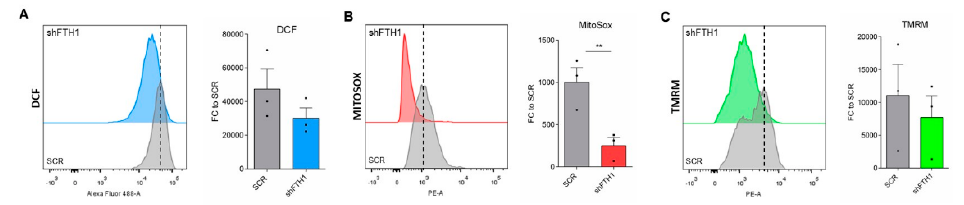
Figure 2. Analysis of ROS levels and mitochondrial functionality in FTH1-KD hESCs. ( A ) DCF staining showed that total cellular ROS levels are reduced in FTH1-silenced hESCs (light blue curve and bar plot) with respect to control cells; ( B ) Mitochondrial superoxide was significantly lower in FTH1-silenced hESCs (red curve and bar plot); ( C ) FTH1-KD cells presented a decrease in mitochondrial membrane depolarization (green curve and bar plot) compared to SCR cells. All data are represented as mean ± SEM ( n = 3); ** p ≤ 0.01, t -test. Small dots refer to SCR replicates, while squares refer to shFTH1 triplicates.